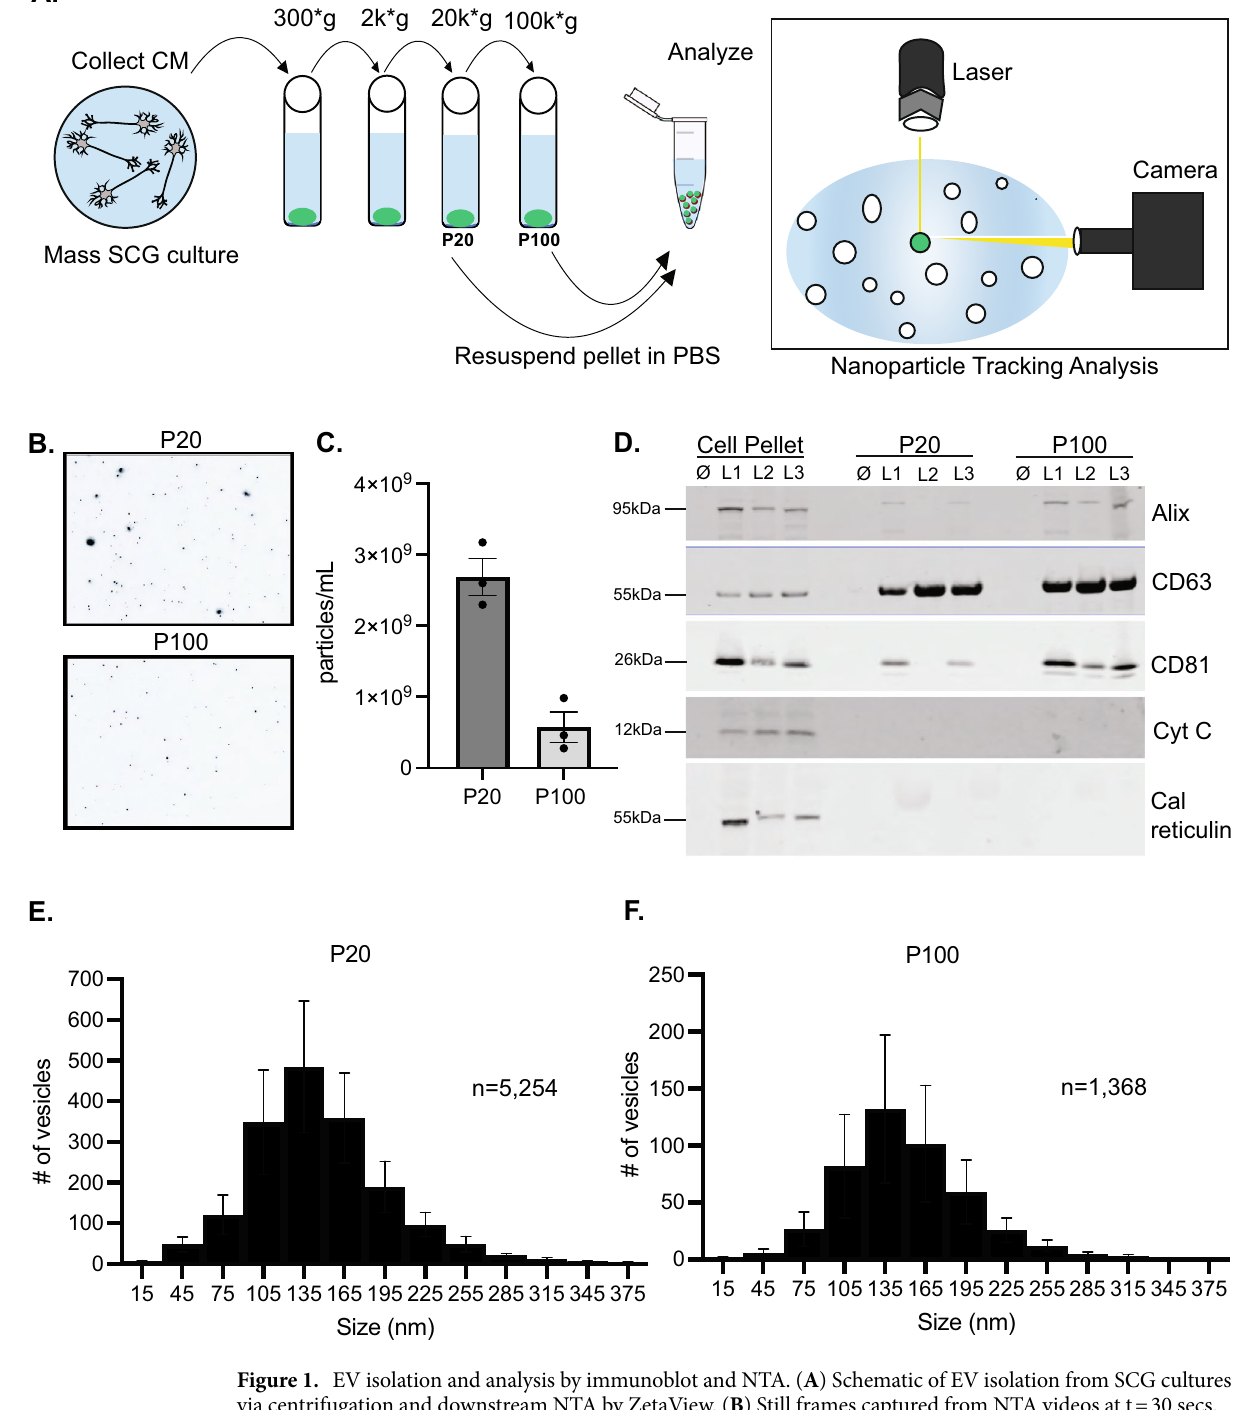
Figure 1. EV isolation and analysis by immunoblot and NTA. ( A ) Schematic of EV isolation from SCG cultures via centrifugation and downstream NTA by ZetaView. ( B ) Still frames captured from NTA videos at t = 30 secs. ( C ) Quantification of the video analysis shown in ( B ). Shown is mean ± SEM for three biological replicates. ( D ) Immunoblot analysis of the canonical EV markers: Alix, CD63, CD81, and the intracellular markers: cytochrome C (mitochondria) and calreticulin (ER). Cell pellet, P20, and P100 fractions from three independent litters (L1, L2, L3) and a “no cell” media control ( ∅ ) are shown. These blots are cropped. Distinct blots are demarcated from each other by white spaces. ( E ), ( F ) Size distribution histogram of 5,254 particles from the P20 fraction and 1,368 particles from the P100 fraction for three biological